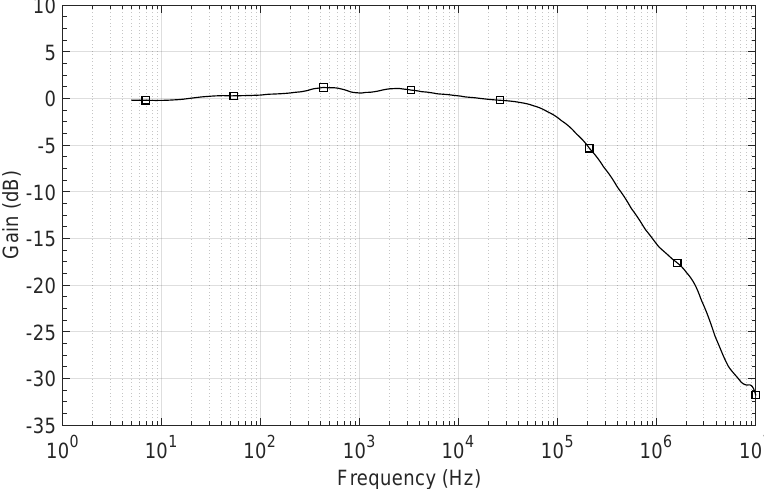
Figure 17. Integrated current buffer SB-CB2 frequency